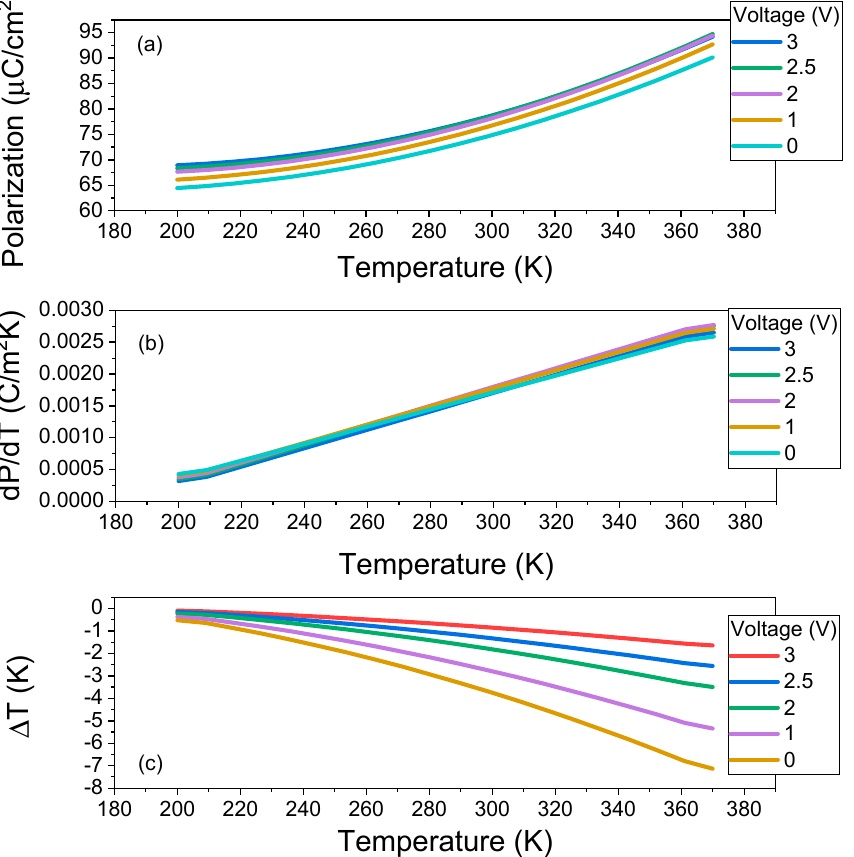
Figure 2. ( a ) The temperature dependence of polarization after switching for different voltages; ( b ) the indirectly evaluated pyroelectric coefficient as a function of temperature and different voltages; ( c ) the indirectly deduced adiabatic temperature variation as a function of temperature and voltages for epitaxial thin film